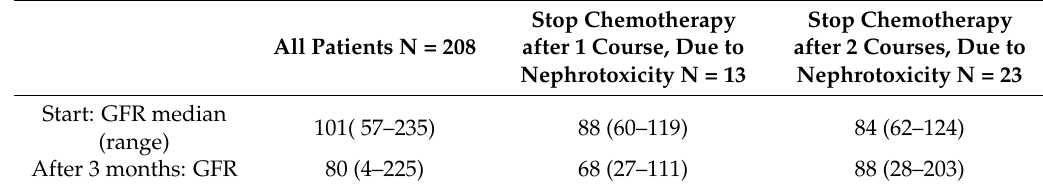
Table 4. Glomular filtration rate in mL/min during and after